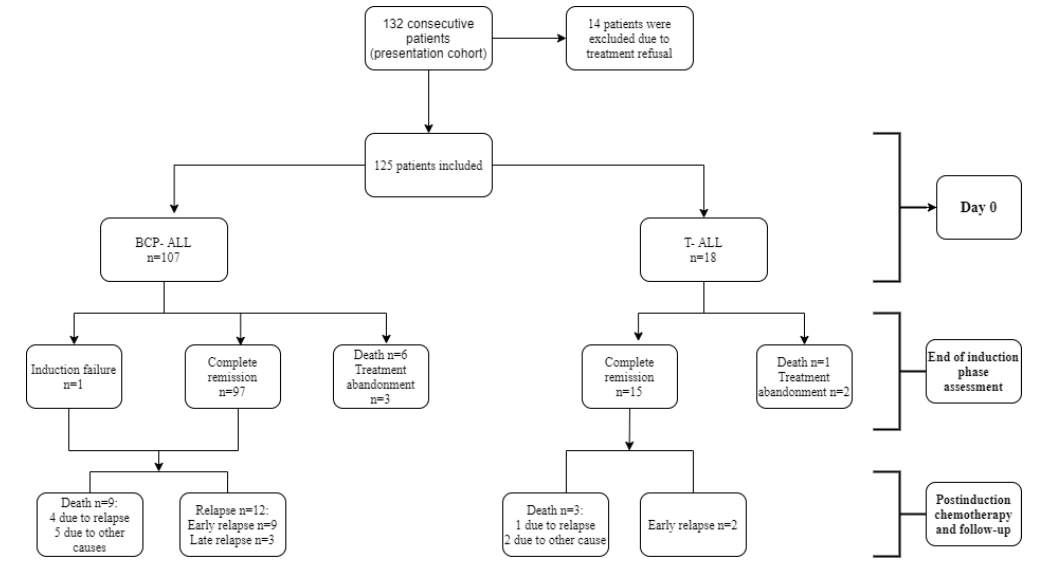
Figure 1. Flowchart of the studied cohort and treatment outcomes. BCP-ALL, precursor B-cell acute lymphoblastic leukemia; T-ALL, T-cell acute lymphoblastic leukemia.